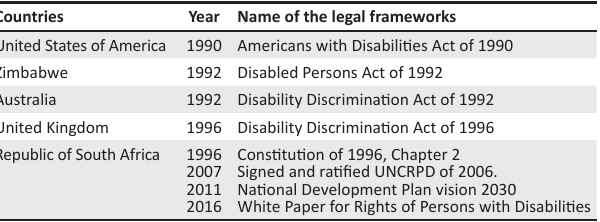
TABLE 1: Examples of countries (SA and the international tourism market) that have pro-disability legal tools.